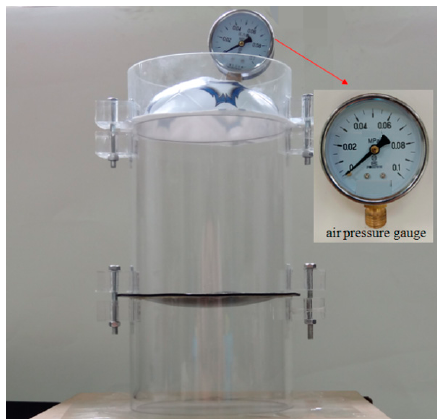
Figure 11. The scheme of the cylinder device.